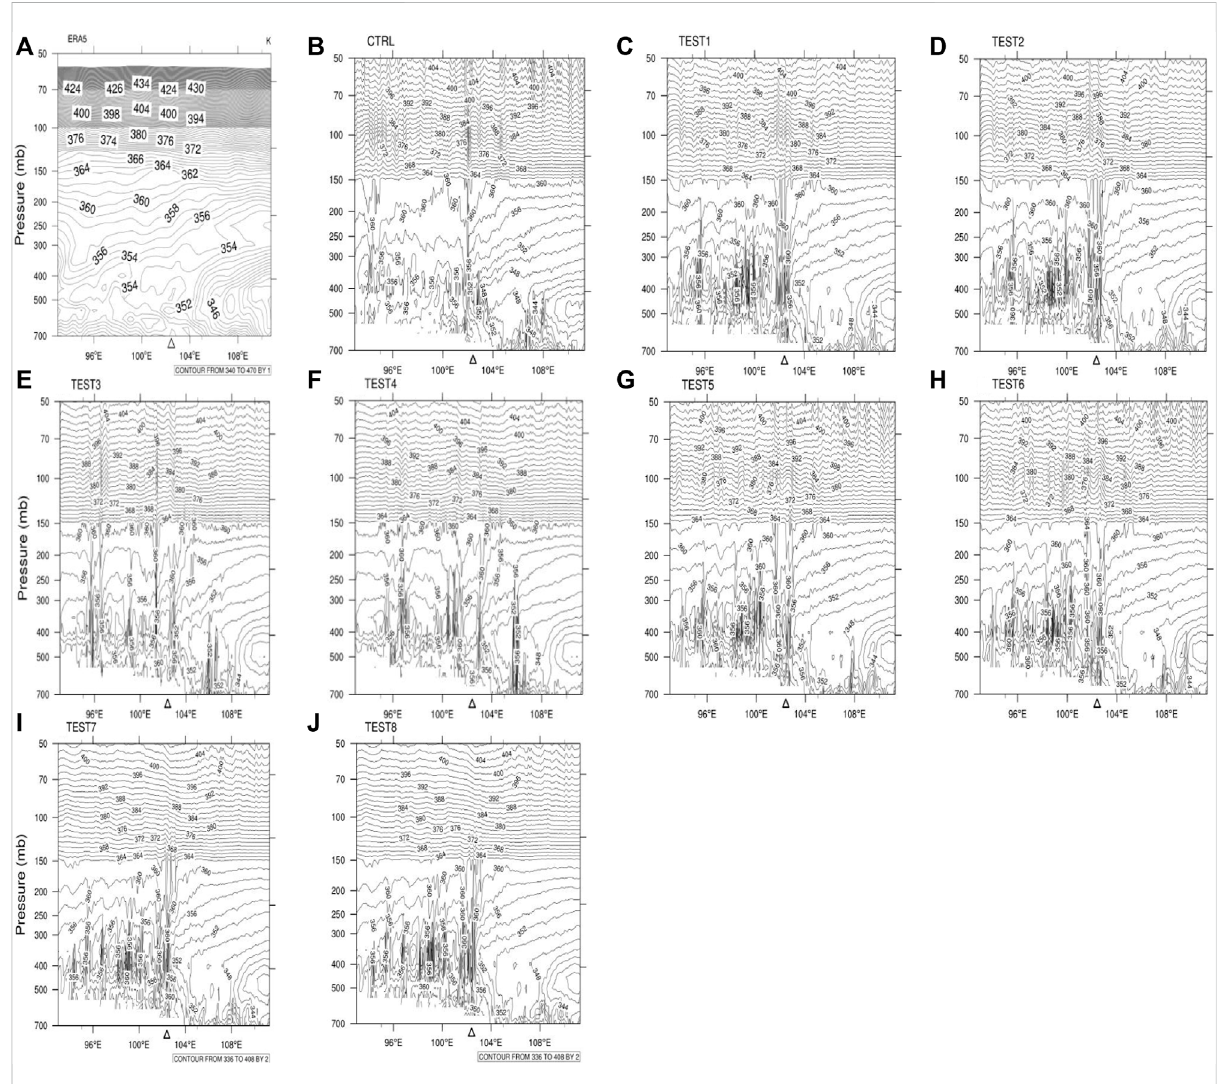
FIGURE 2 Vertical pro fi les of the pseudoequivalent potential temperature at 1900 on 22 June 2016 over Area A (units: K) (A) ERA5, (B) CTRL, (C – J) TESTs 1 –